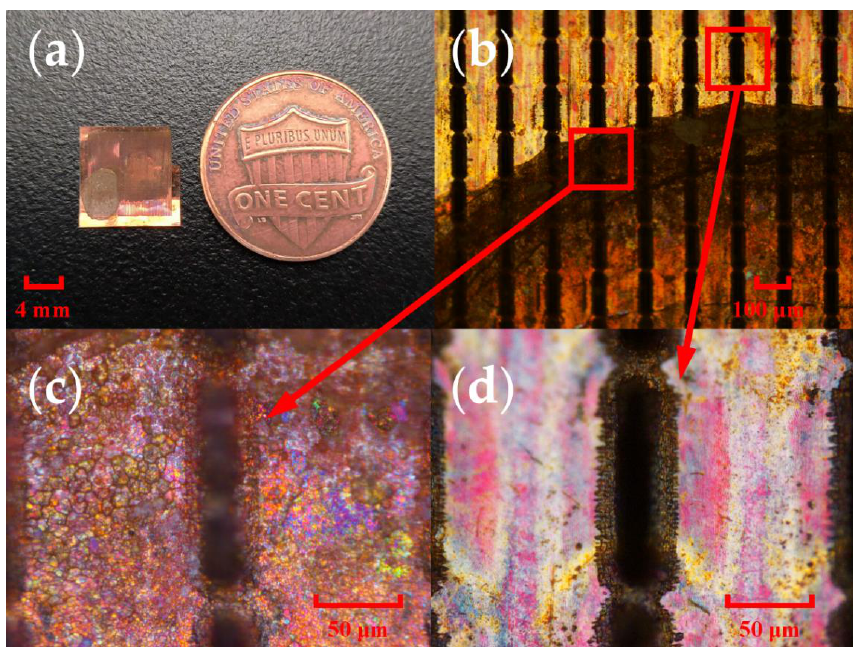
Figure 6. Sample transfer images: ( a ) Metamaterials after deposition of UA; ( b ) Edge of deposition area; ( c ) Slot unit after deposition; ( d ) Slot unit in clear area.